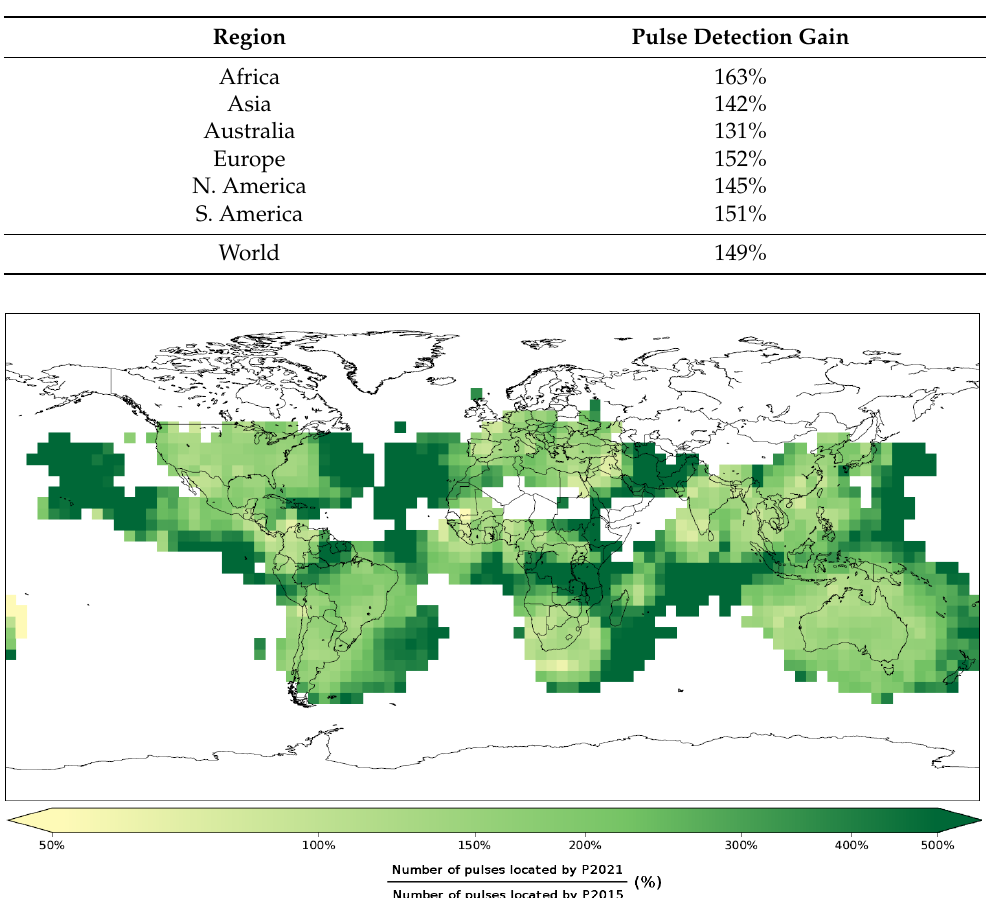
Figure 3. Comparison of the total number of ENTLN pulses detected by P2021 and P2015 between December 3rd, 2021 and April 14th, 2022. Pixels with less than 1000 events detected by P2015 and P2021 are not shown. Note the detection gains shown here are gains for only ENTLN-detected pulses and contributions from the World Wide Lightning Location Network (WWLLN) were excluded in the